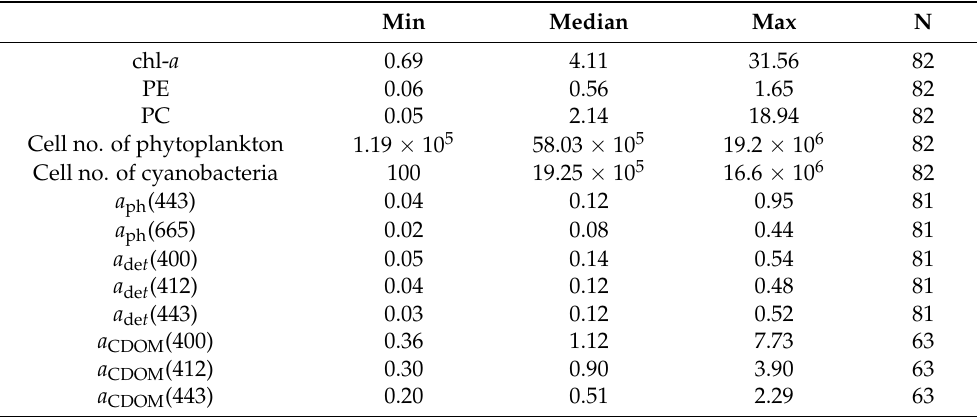
Table 2. Descriptive statistics for chosen water parameters.